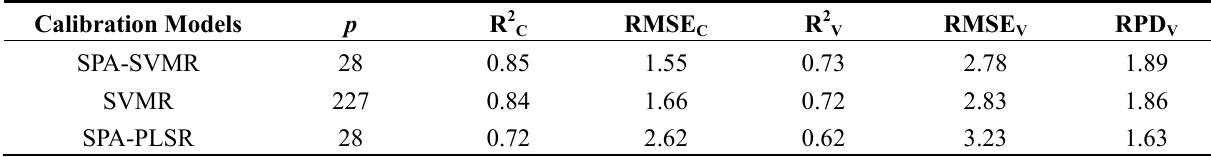
Table 5. The performance of the SPA-SVMR, SVMR and SPA-PLSR models for SOC contents